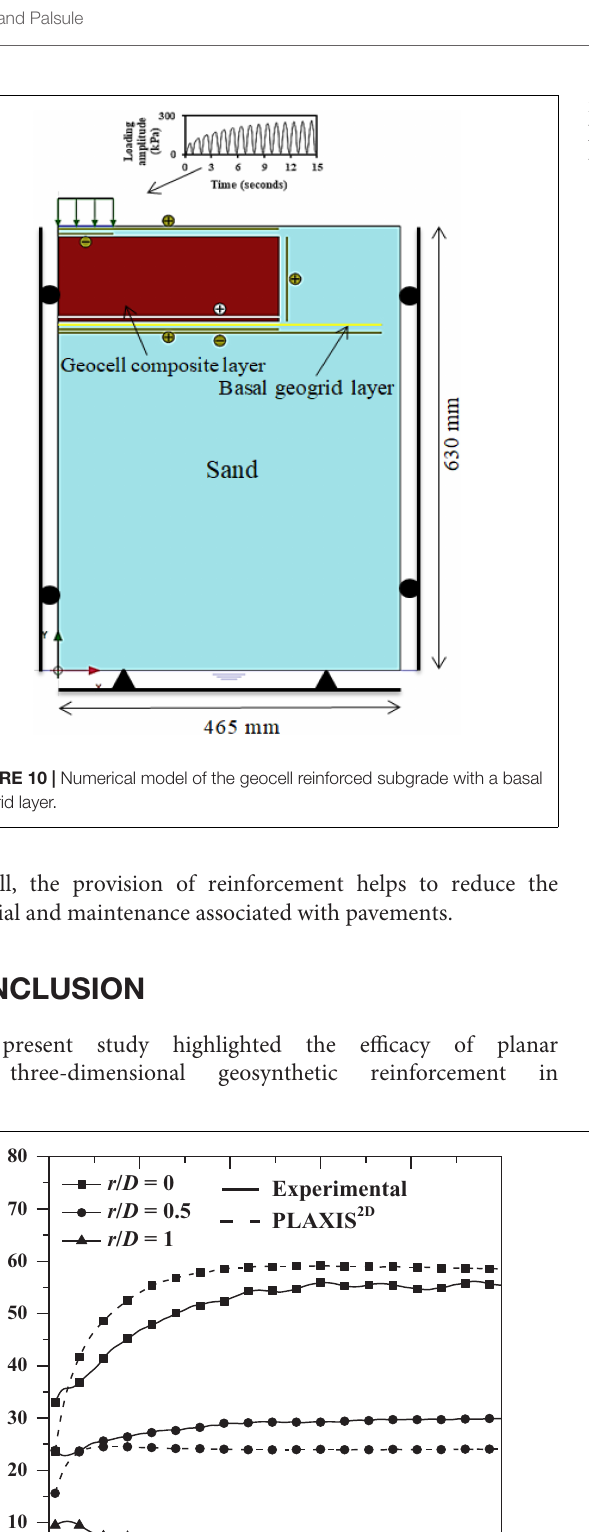
Frontiers in Built Environment |